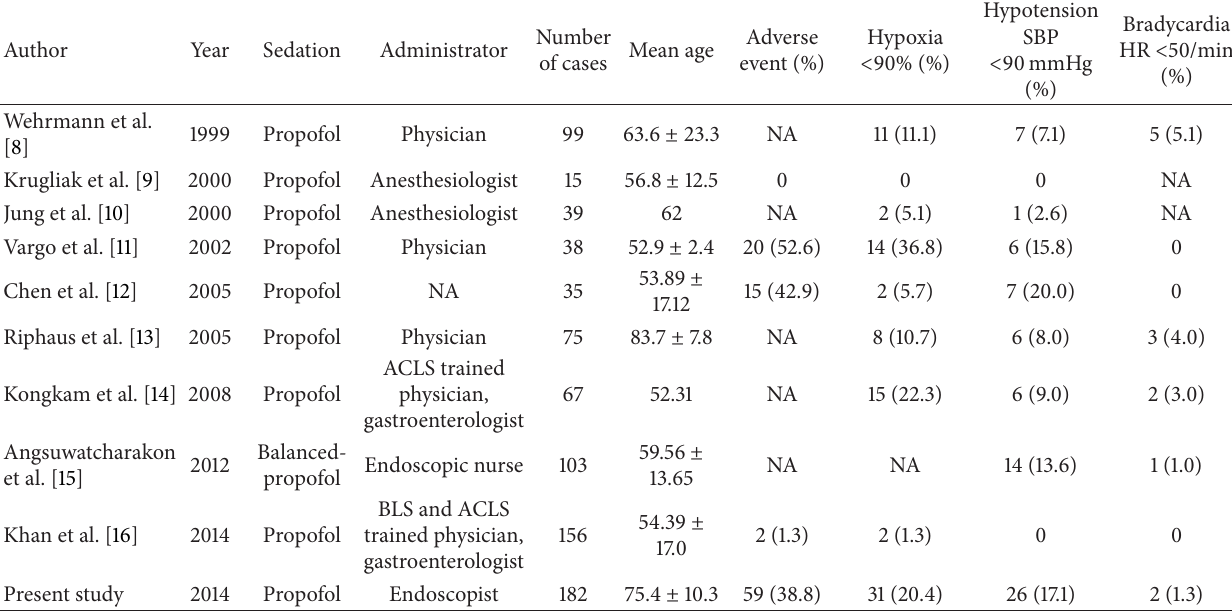
Table 5: Summary of reports in the literature on ERCP with propofol